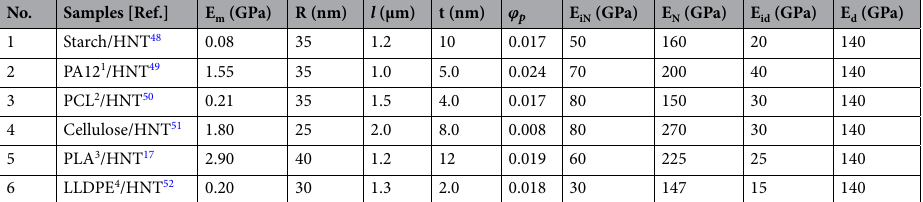
Table 1. Real examples from valid articles, and estimation of various factors by using the developed equations. 1 Polyamide 12. 2 Poly(ε-caprolactone). 3 Poly(lactic acid). 4 Linear low density polyethylene.